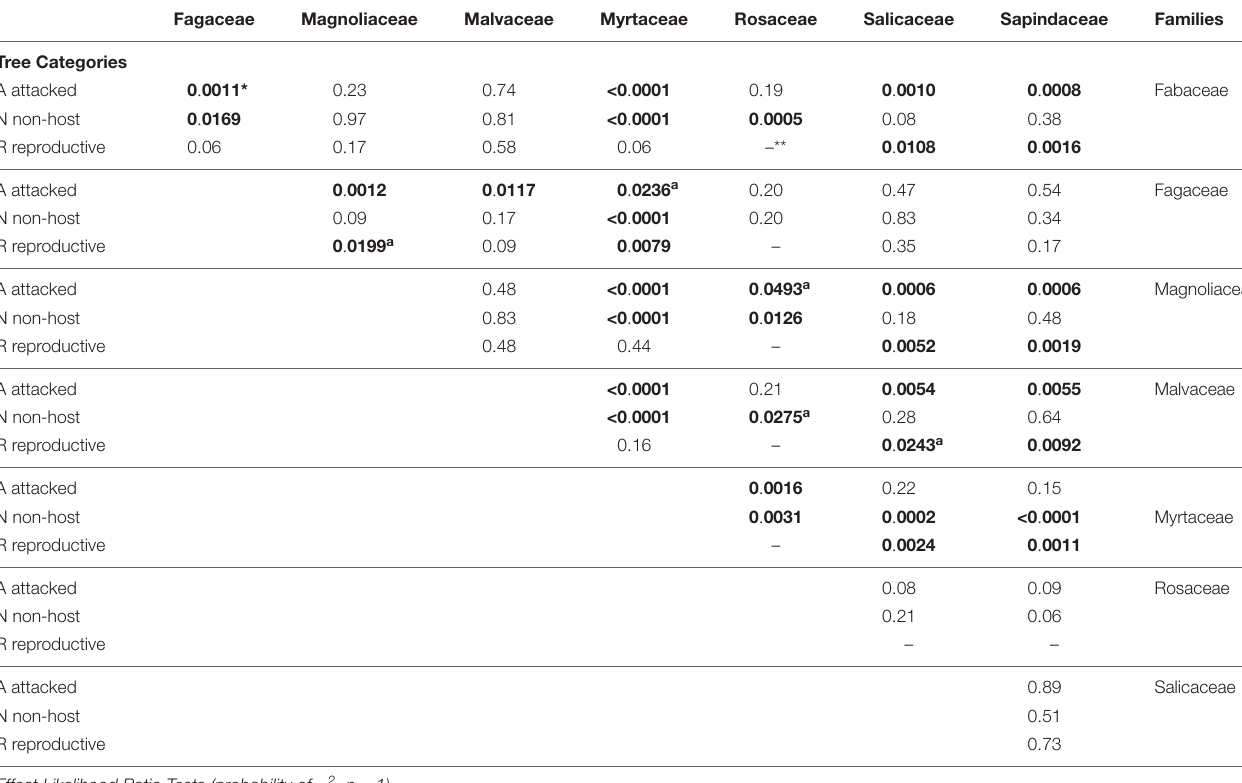
TABLE 4 | Comparison of % tree species of each category between eight botanical families.